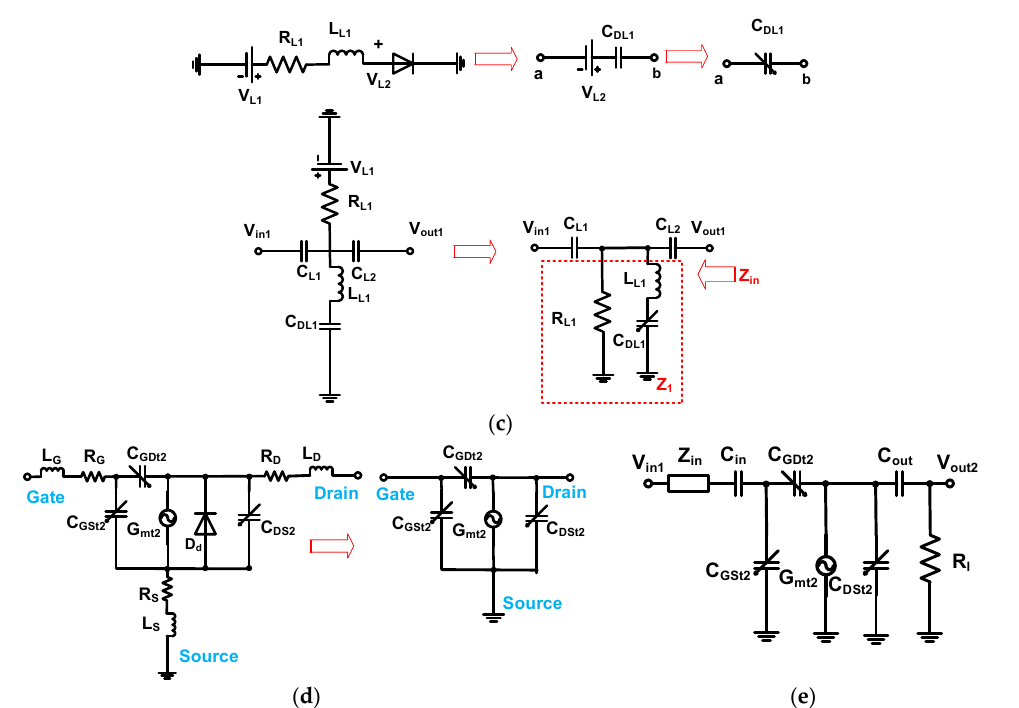
Figure 2. ( a ) Schematic diagrams and ( b ) implemented PA with shunt-diode pre-linearizer; the equivalent circuit models of the ( c ) diode and shunt-diode pre-linearizer, ( d ) large signal non-linear power MOSFET (metal-oxide-semiconductor field-effect transistor), and ( e ) PA with shunt-diode pre-linearizer. The diode current can be represented as followed by